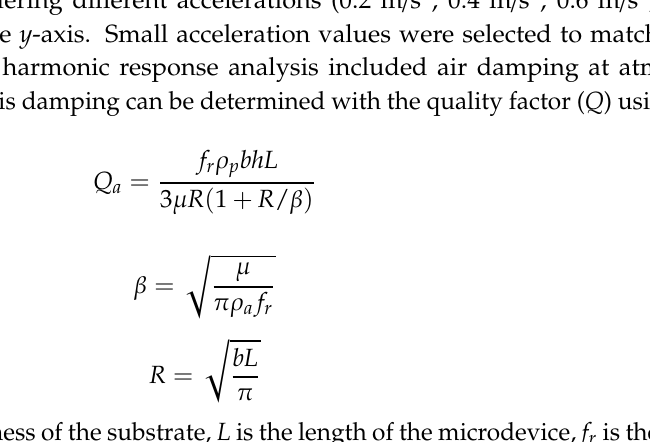
Figure 14. Schematic view of the variation of the resonant frequency of the pVEH microdevice caused by the modification of the thickness of seismic mass. Different applications of the pVEH microdevice can be obtained adjusting the thickness of seismic mass. Research of pVEH microdevices has rapidly advanced in the last two decades due to their potential application to supply electrical energy to portable devices. However, these microdevices have challenges such as electric fatigue [17], resulting in reduced switching polarization after a few cycles of operation, and the brittle nature [18] of the ceramic piezoelectric materials (e.g., PZT). Therefore, the purpose of this work was to develop an alternative synthesis (solvothermal) and low- cost fabrication based on a spraying technique for the films deposition on flexible pVEH microdevices. With the flexible PET substrate, the microdevice can achieve high deformations and high stress on the nanostructured piezoelectric film. Thus, the pVEH microdevice can increase its